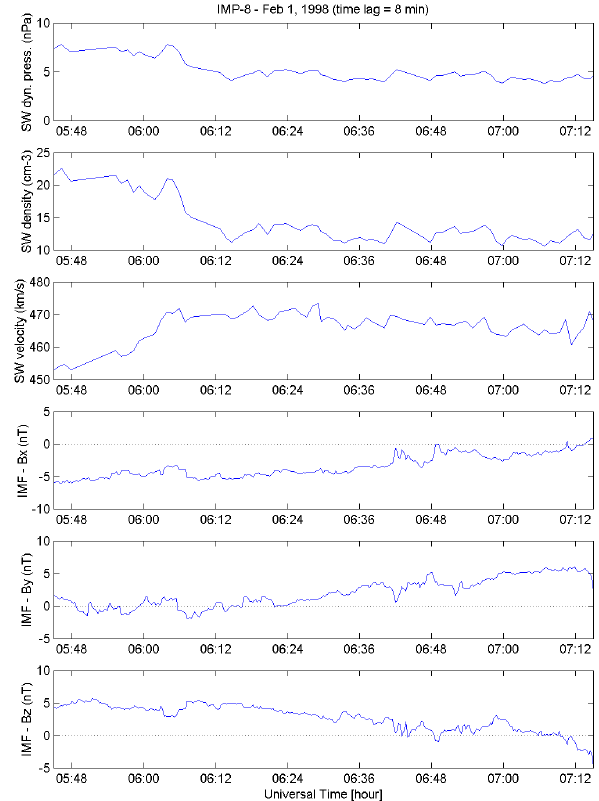
Fig. 2. Solar wind parameters and interplanetary magnetic field measured at